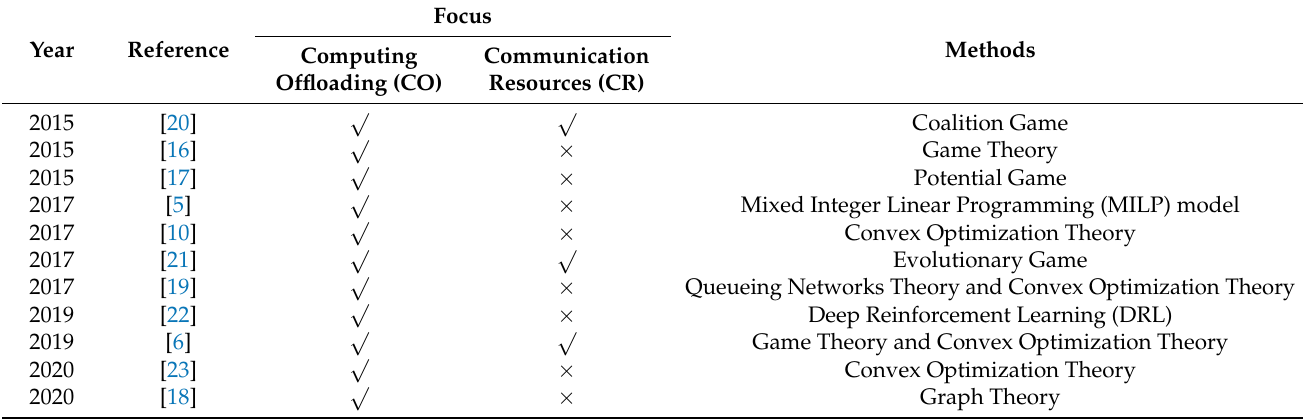
Table 2. Comparison of references of computation offloading (CO) and communication resources (CR). ( the topic is covered. ( × ) indicates that the topic is not